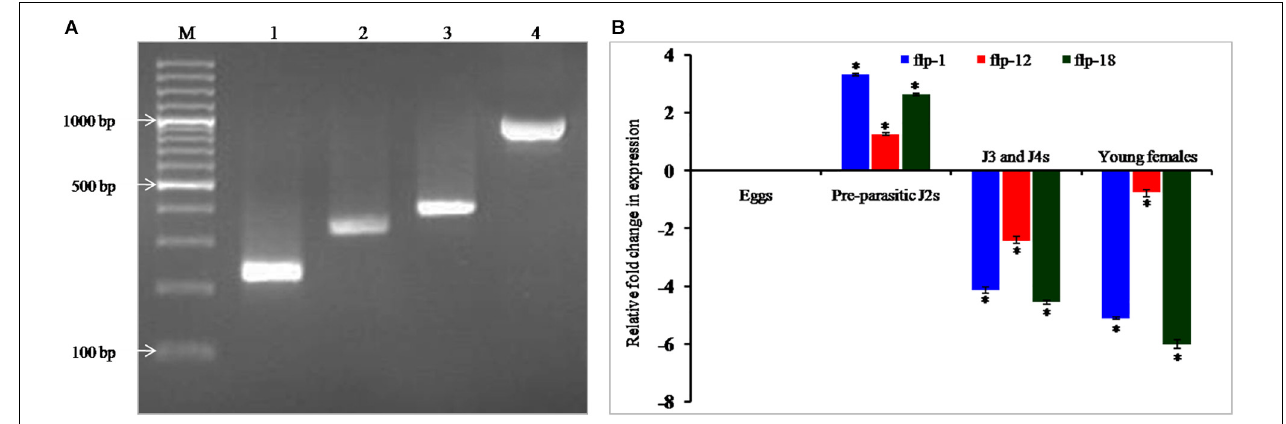
FIGURE 1 | (A) PCR amplification of FLPs of M. incognita. Lanes – 1 : Mi-flp1 , 2 : Mi-flp12 , 3 : Mi-flp18, 4 : FLPs-fusion cassette, M: 100 bp marker, (B) Relative fold-change in the target genes expression in different developmental stages of M. incognita . Each bar represents the mean ± SE of n = 3, and asterisks indicate significant difference at P <